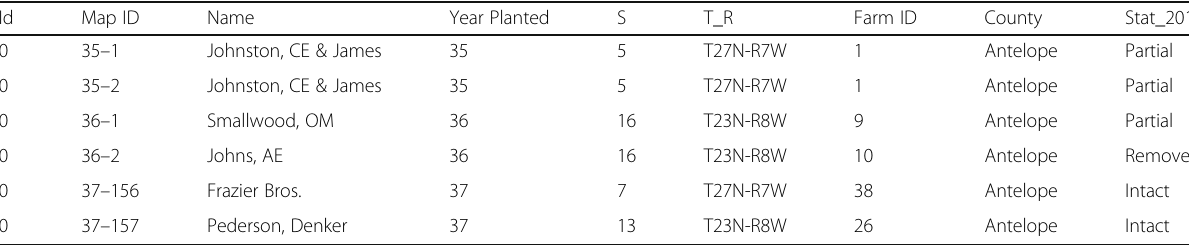
Table 2 Fields in attribute table for each shelterbelt